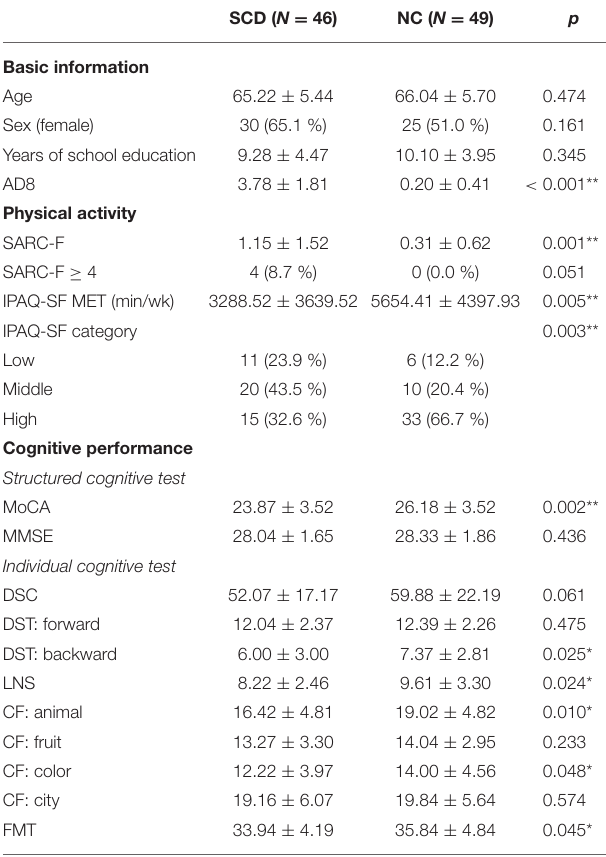
TABLE 1 | Comparisons between the SCD and NC